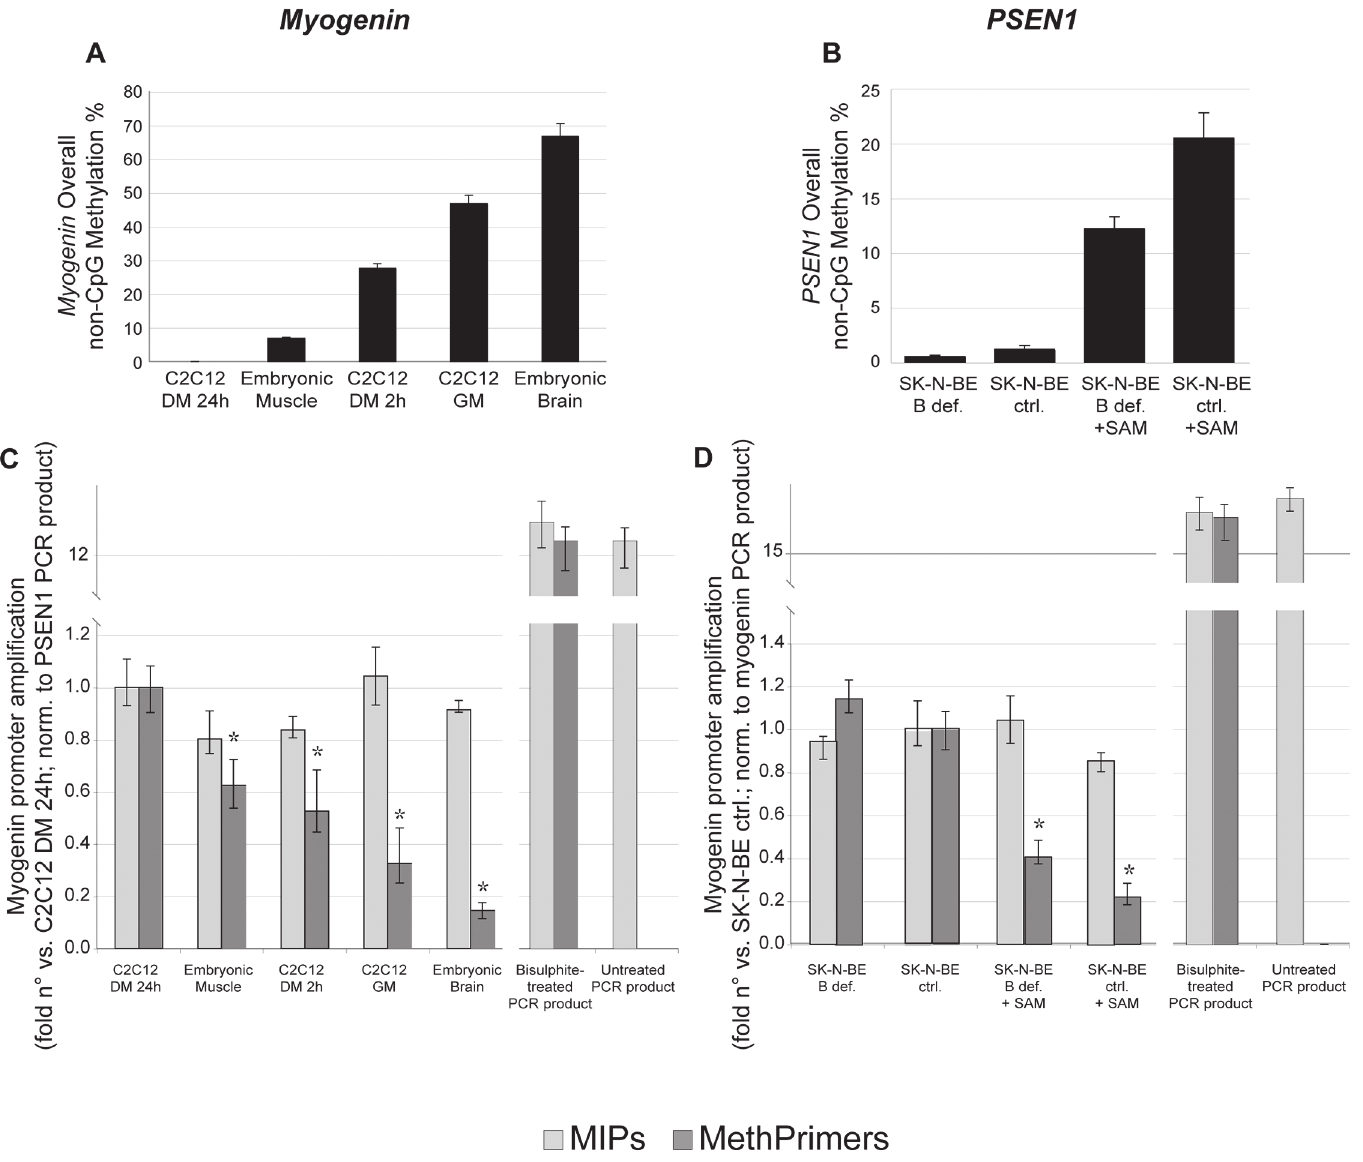
Fig 2. MethPrimers amplification efficiency is affected by DNA methylation. a) Myogenin and b) PSEN1 overall non-CpG methylation. c) and d) Amplification efficiency of primers on samples with differential overall non-CpG methylation was assessed by Real-Time PCR assay using MIPs (light grey columns) or MethPrimers (dark grey columns) for myogenin (c) and PSEN1 (d). Bisulphite-treated PCR products and untreated PCR products were used as control of amplification efficiency. Values are expressed as fold n° versus control (C2C12 in 1% 24 hours for myogenin , SK-N-BE in complete medium for PSEN1 used as respective calibrators ); myogenin amplification values were normalized using PSEN1 PCR product amplification (added to mouse samples and used as exogenous reference) whereas PSEN1 amplification values were normalized to myogenin PCR product amplification (in this case added to human samples and used as exogenous reference). * : p < 0.001 vs.